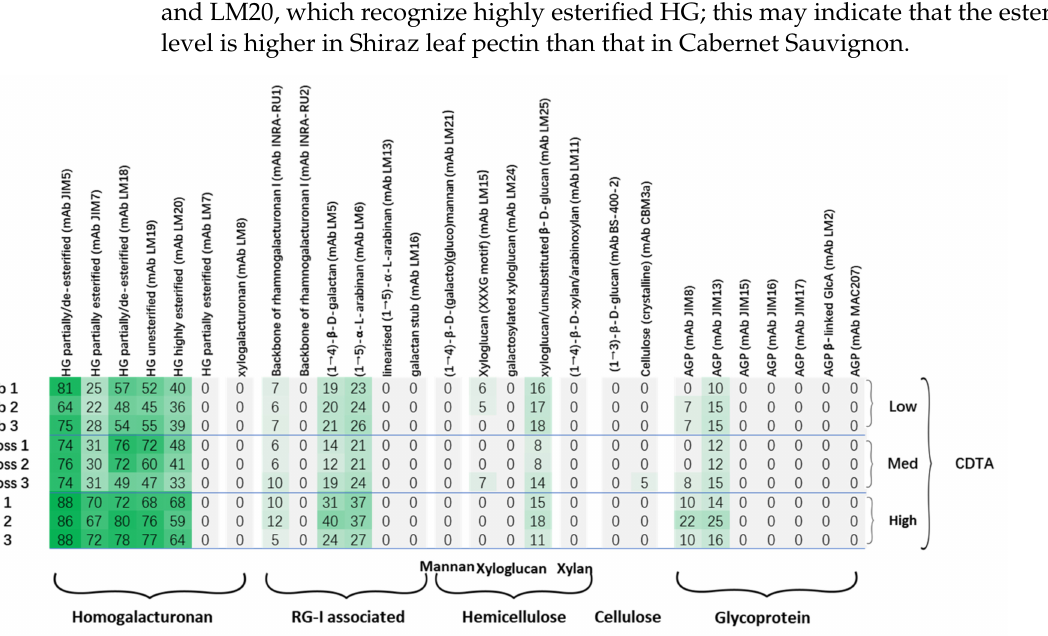
Figure 2. Comprehensive Microarray Polymer Profiling (CoMPP) analysis of CDTA extract of grapevine leaf cell wall AIR samples. The heatmap shows the relative abundance of plant cell wall glycan-associated structural motifs. The highest signal was set as 100, and others were adjusted accordingly; the color intensity is correlated to the mean spot signal. A cut-off (<5) was